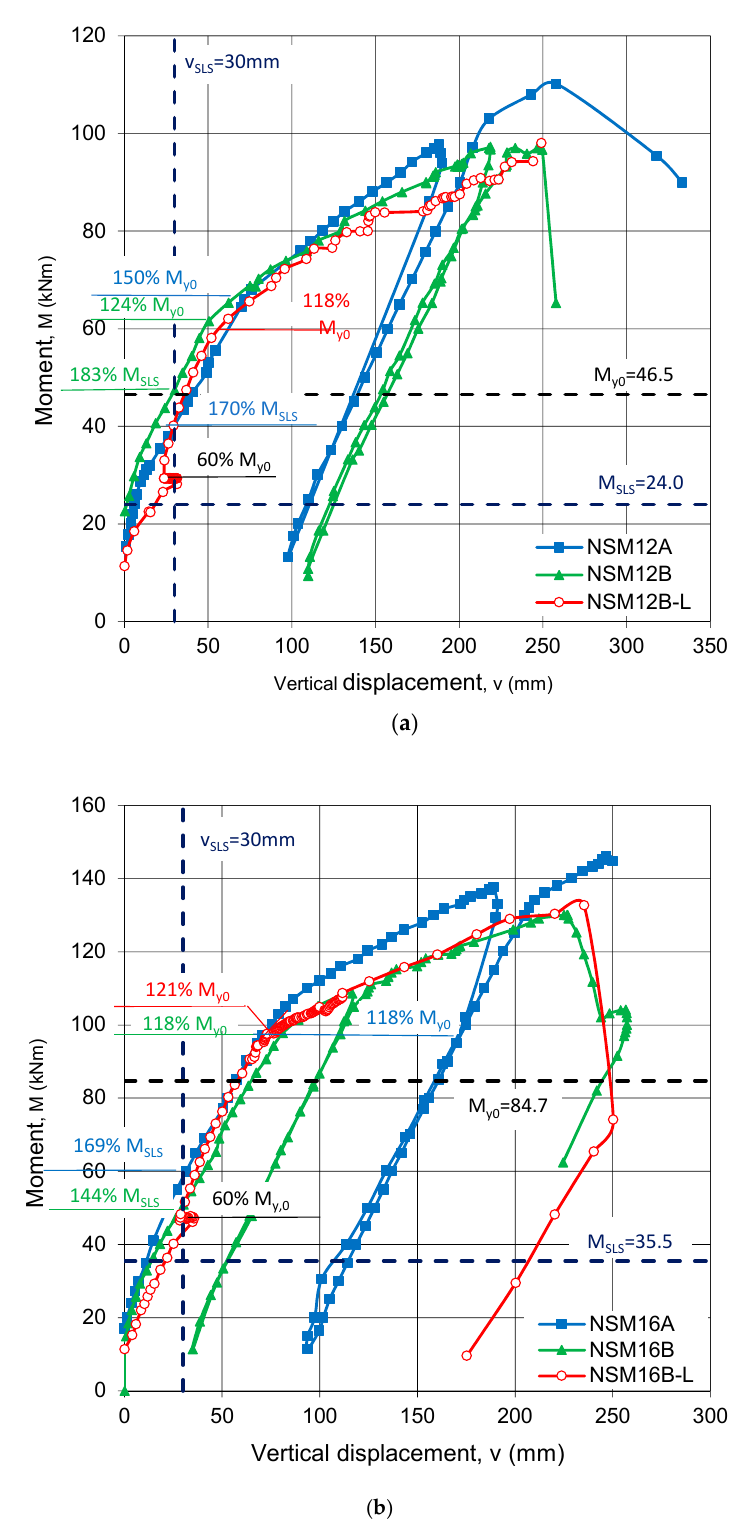
Figure 12. Bending moment vs. vertical displacement curves: ( a ) Series A; and ( b ) Series B.